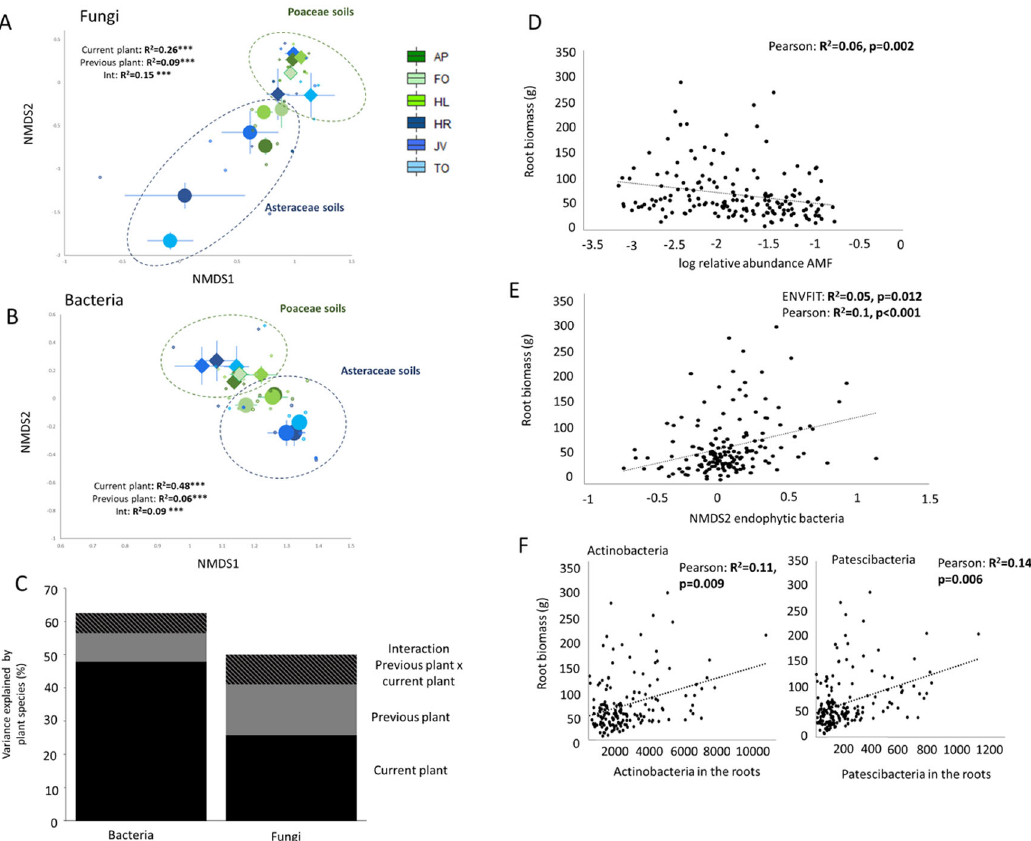
Fig. 6 Endophytic microbes and their effects on plant growth. Fungal and bacterial root endophytes affected by previous and current plant species and functional groups and their relationship with responding plant growth. A , B NMDS using Bray-Curtis distance on the effect of current plant (colors: green shades depict Poaceae, blue shades depict Asteraceae) and previous plant functional group (shapes; circles represent Asteraceae soils and triangles Poaceae soils) on fungal ( A ) and bacterial ( B ) community structure. PERMANOVA results ( R 2 and signi fi cance) for the model are given in the fi gure and *** notes signi fi cance at the level p < 0.001. C variance in root endophytic bacterial and fungal community structures explained by conditioning (previous) and responding (current) plant and their interaction. D the relationship (Pearson correlation) between (log relative abundance of) AMF inside the roots and plant belowground biomass. E relationship between root biomass and bacterial community structure measured by NMDS2 (Pearson correlation) and by using all the data and full model (ENVFIT), and F read numbers of two bacterial phyla (Actinobacteria and Patescibacteria) most strongly correlated with belowground biomass (after FDR correction). For all of the bacterial phyla and fungal classes see fi g. S5. The 2D stress values for the root microbiomes were 0.12 for fungi and 0.08 for